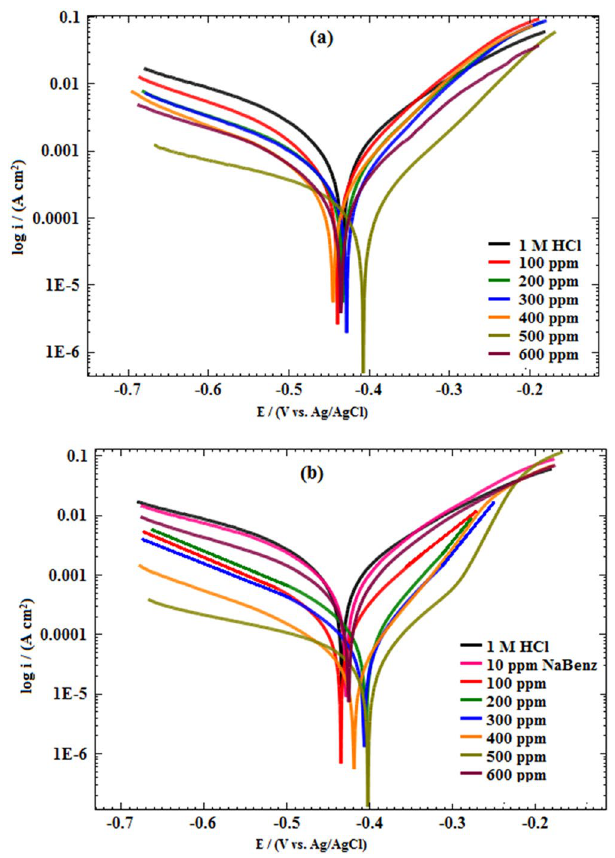
Figure 3. Potentiodynamic polarization curves of MS in 1M HCl solution without and with different concentrations of LPr and LPr + 10 ppm NaBenz.